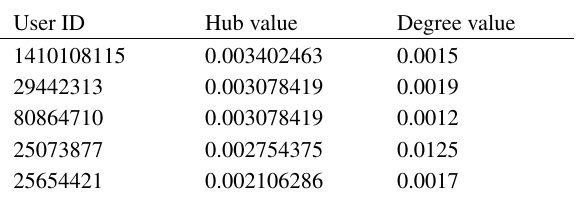
Table 6 Results of identification of influential spreaders.